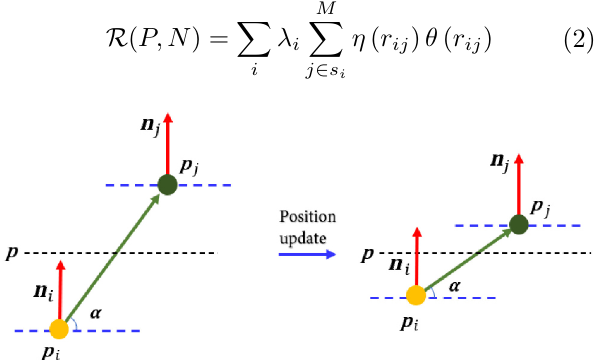
Fig. 2 Left: original points. Right: updated points. p i and p j are the current point and a neighboring point respectively. n i and n j are the normals of p i and p j , respectively. A local plane surface is assumed.